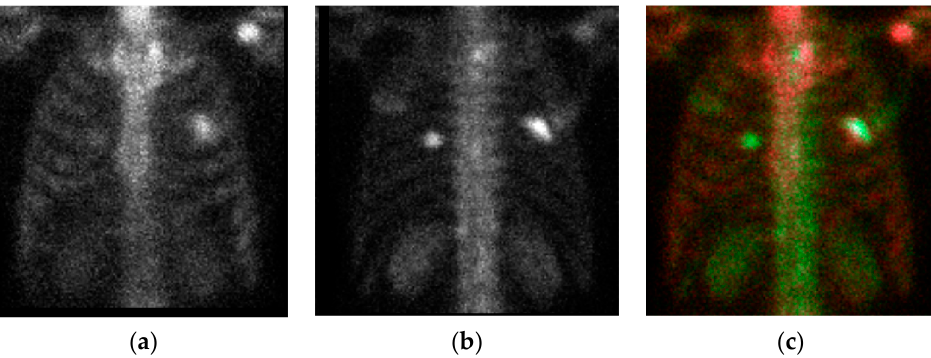
Figure 2. The chest images. ( a ) anterior–posterior (AP) view; ( b ) flipped posterior–anterior (PA) view; ( c ) the combined chest color image for input into the NN (neural network).